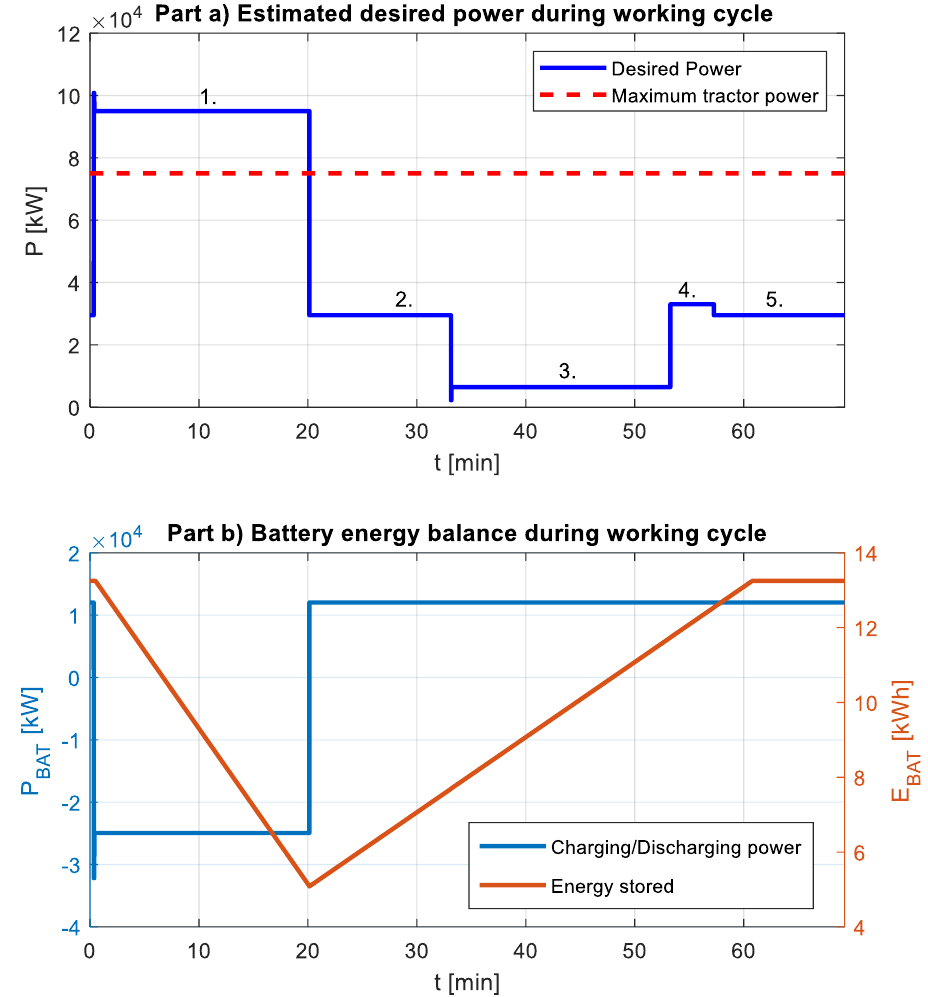
Figure 5. ( a ) Course of the power required during the demanding working cycle — the loaded tractor − trailer unit (potentiometer setting at 50%) travels uphill (gradient 15 ◦ ) over an unpaved surface. ( b ) Charging/discharging battery power and energy balance during the described working cycle. The parts of working cycle are numbered according to Tables 1 and 2 (author: Ivo Pazdera).